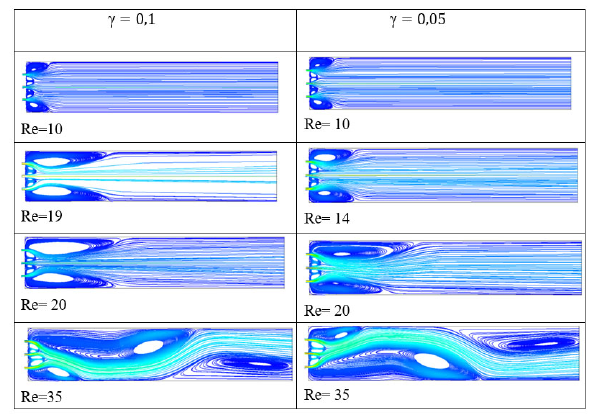
Figure 10: Streamlines of characteristic flows for γ = 0.05, 0.1 in three